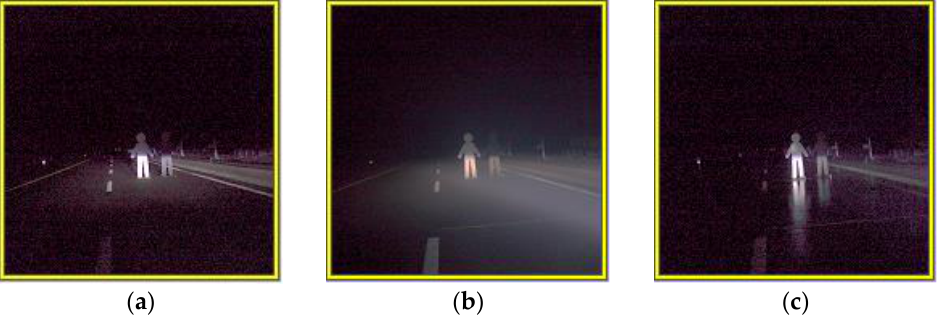
Figure 10. Examples of measurements in conditions of pedestrian target distance of 12.5 m and color temperature of 6000 K: ( a ) Clear condition; ( b ) fog condition with a visibility of 100 m; ( c ) rain condition with a rainfall of 20 mm/h.